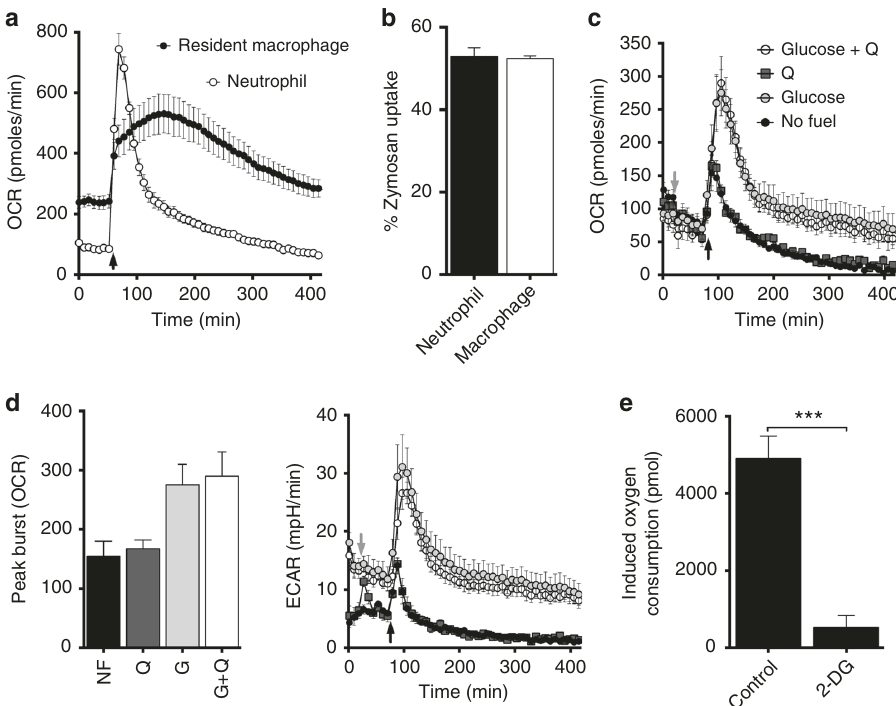
Fig. 4 Glutamine does not support neutrophil respiratory burst. a Line plot of OCR vs time in peritoneal tissue-resident macrophages and bone marrow neutrophils. Arrow indicates the addition of zymosan (50 μ g/ml). Data are from two separate experiments and represent at least three